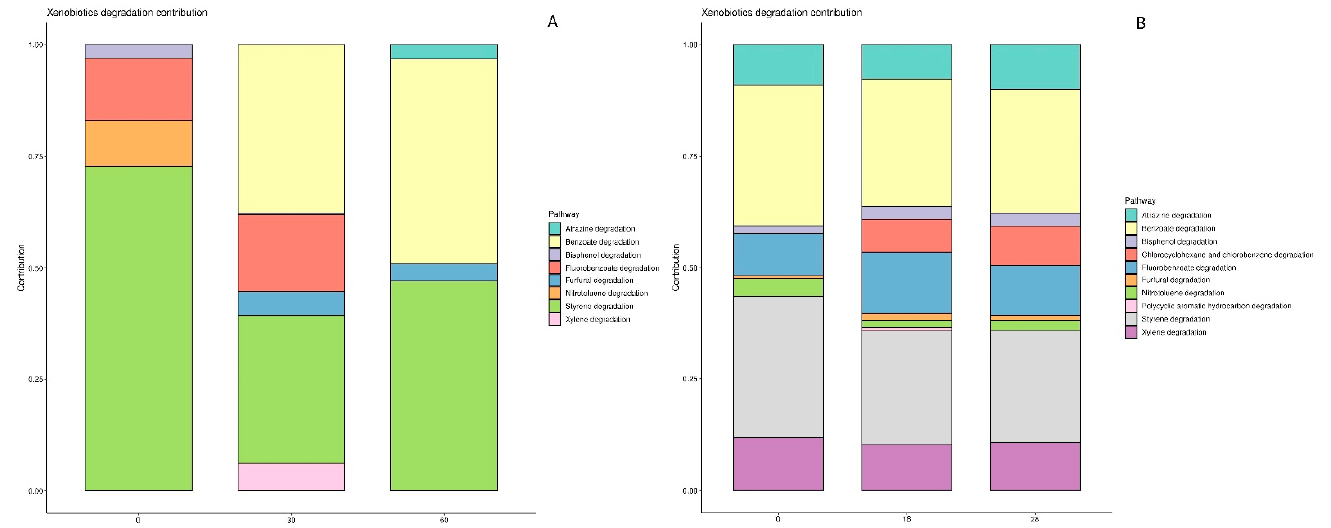
Figure 8. Barplot of xenobiotic contributions. Barplots showing the relative distribution of KEGG pathways under xenobiotic degradation family for panel ( A ) SMS and panel ( B ) Lambertella sp. MUT 5852, calculated by PICRUSt2.